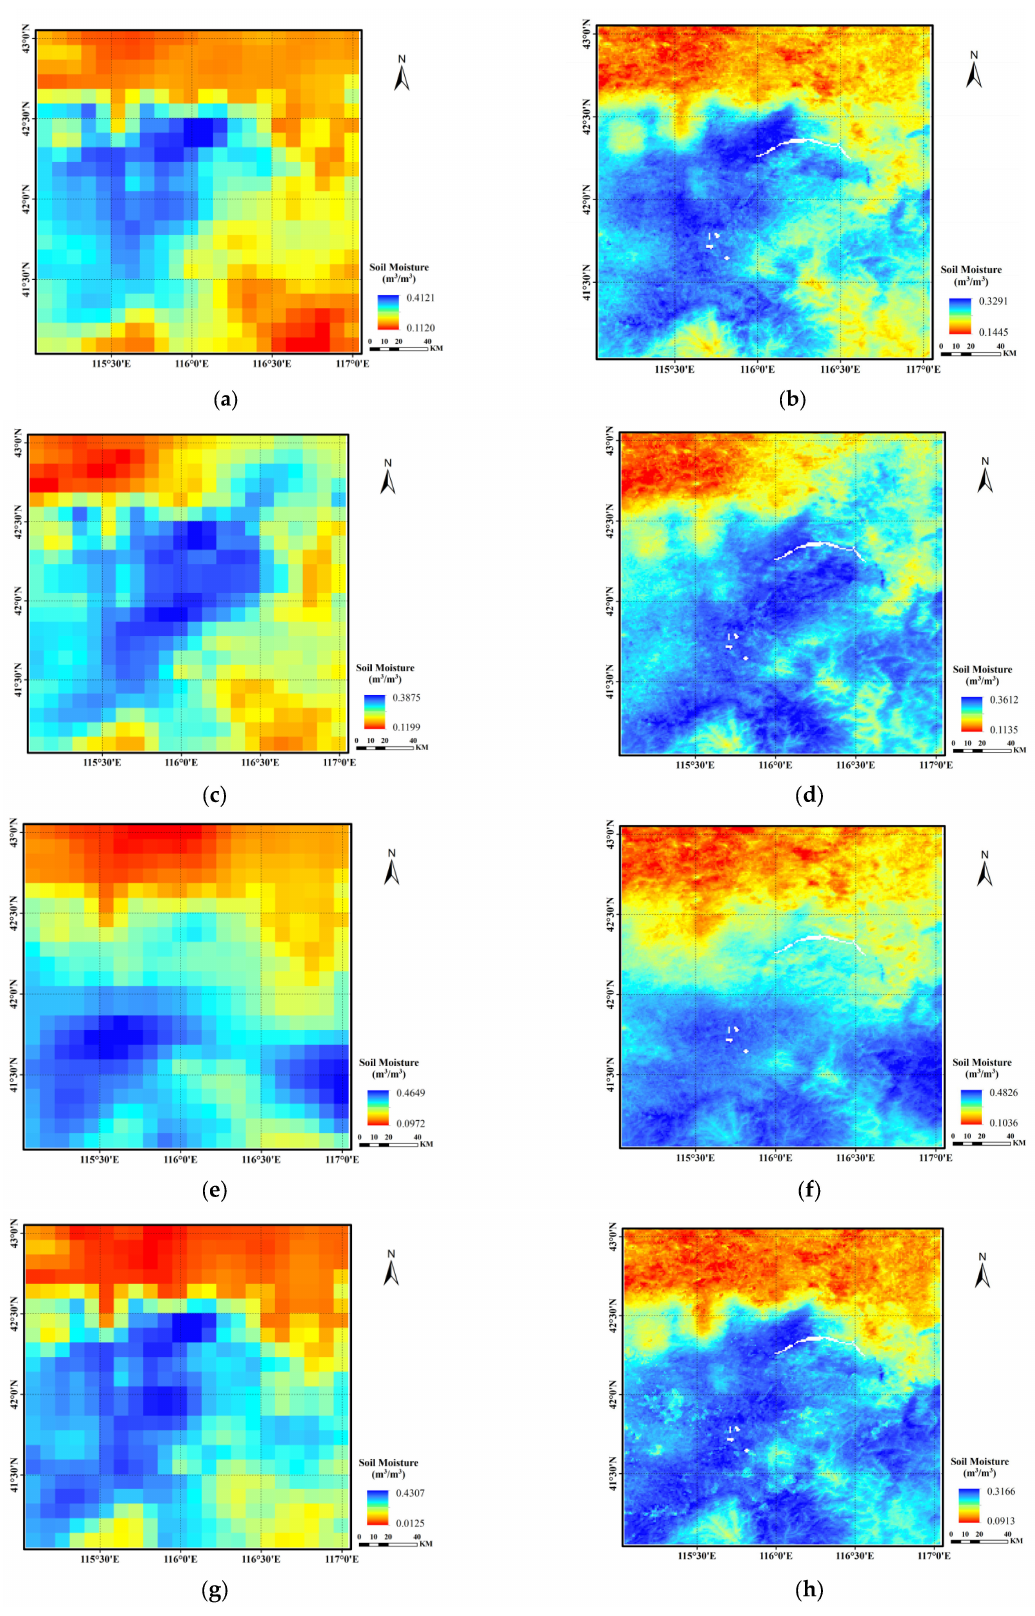
Figure 7. Comparison of original SMAP SM data ( a , c , e , g ) and corresponding downscaling result ( b , d , f , h ) of different dates (25 March, 25 May, 25 July and 25 November 2019, note: white part is a result of using the water